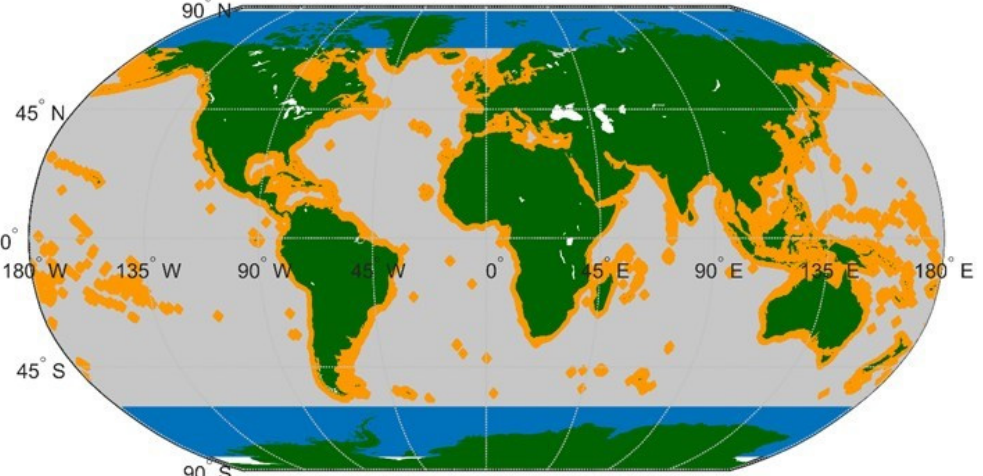
Figure 1. GOW2 mesh domains. Grey: global (0.5 × 0.5 degrees), blue: Arctic and Antarctic (0.25 degrees latitude × 0.5 degrees longitude) and orange: coastal mesh (0.25 × 0.25 degrees).